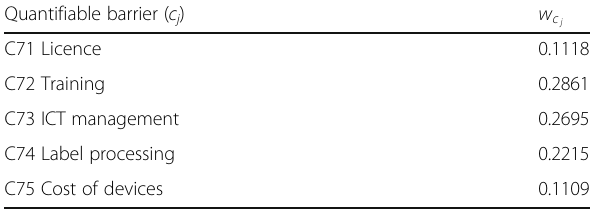
Table 4 Local normalised weights of quantifiable barriers Quantifiable barrier ( c j